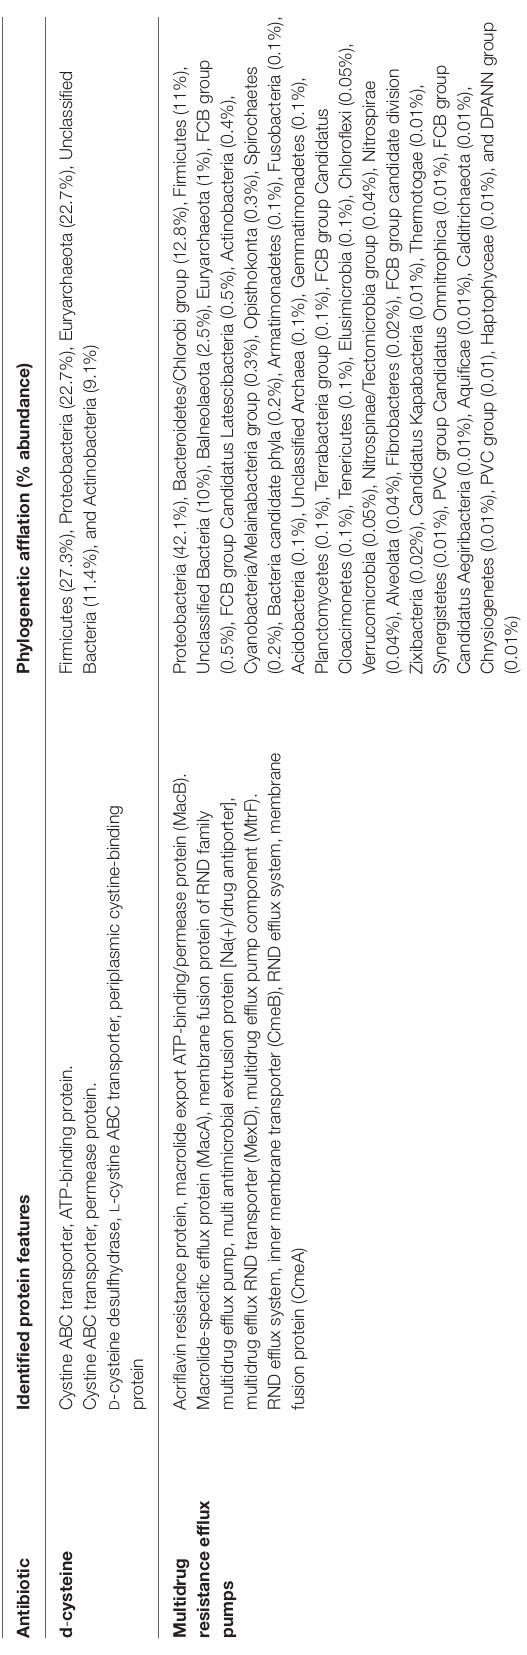
level of taxonomic hierarchy ( Supplementary Figures 3 , 4 ). The plot showed an abundance ( > 70%) of Thermotogae, Tenericutes, and Bacillariophyta among the alkaline ecosystem, observed for freshwater and salt environment ( Supplementary Figure 3 ). Ternary plots with phylogenetically affiliated protein features at the class level of taxonomic hierarchy indicated that Thermotogae, Planctomycetia, and